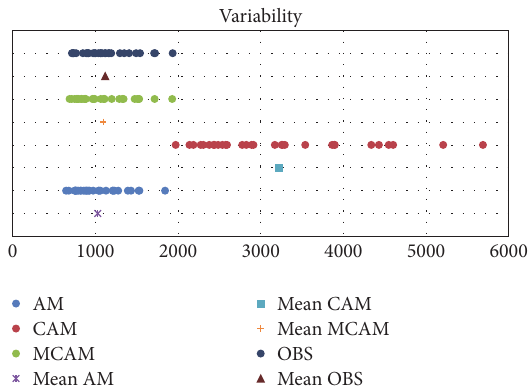
Figure 17: The variability plot from AM, CAM, and MCAM.